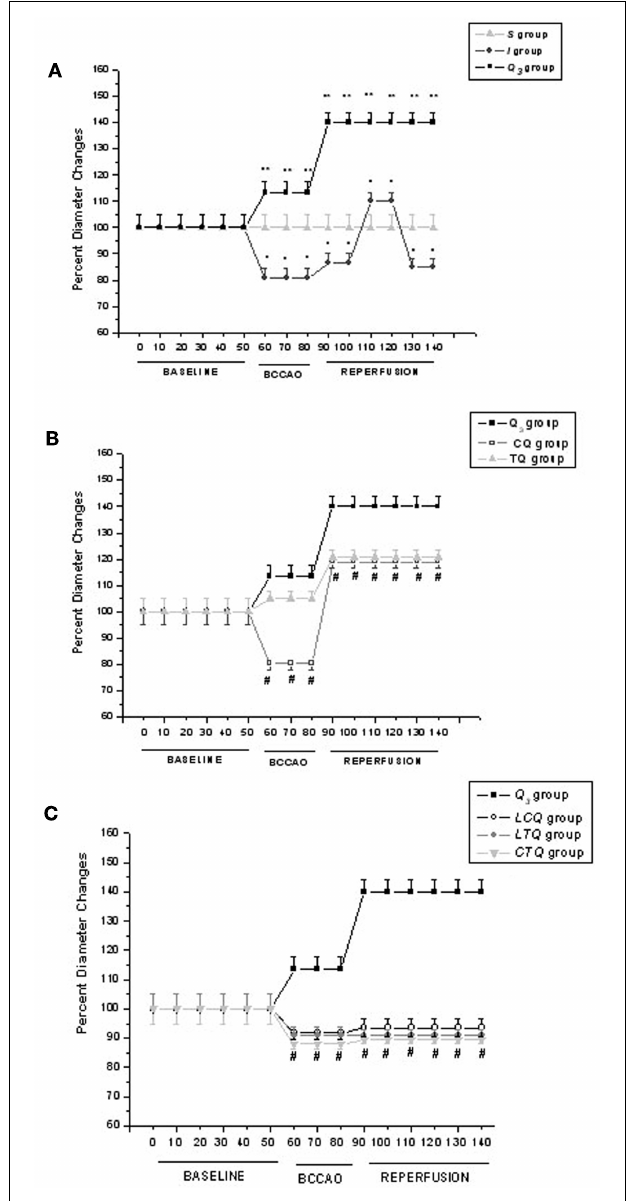
FIGURE 1 |Time course plots of diameter changes in the experimental groups. (A) Diameter changes of order 2 arterioles, expressed as percent of baseline, under baseline conditions and during BCCAO and reperfusion in sham-operated group (S), in ischemic group (I) and in quercetin (5.0mg/Kg b.w.) treated group (Q 3 ); (B) Diameter changes of order 2 arterioles, expressed as percent of baseline, under baseline conditions and during BCCAO and reperfusion in quercetin (5.0mg/Kg b.w.) treated group